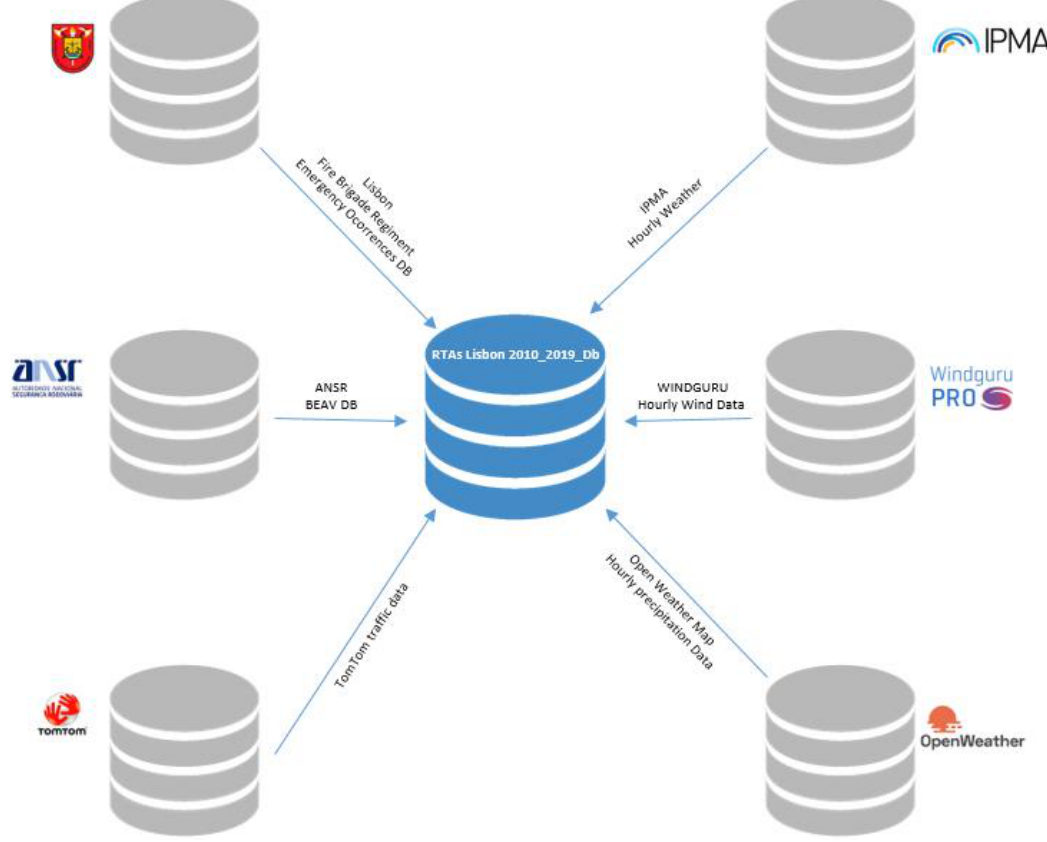
Figure 2. Data Sources and ETL Process performed.